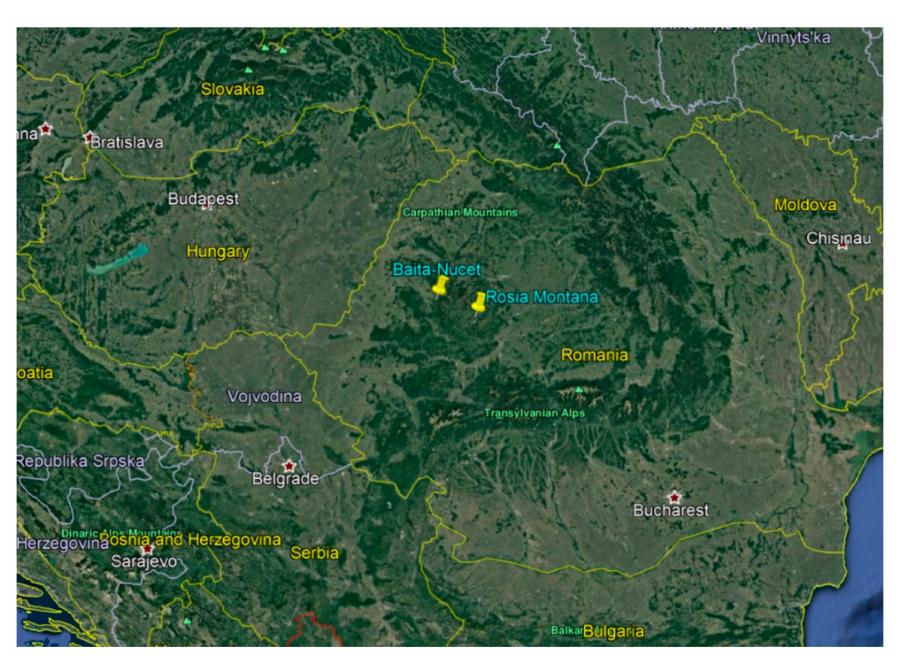
Figure 1. Geographical location of the two studied mining areas (source—Google